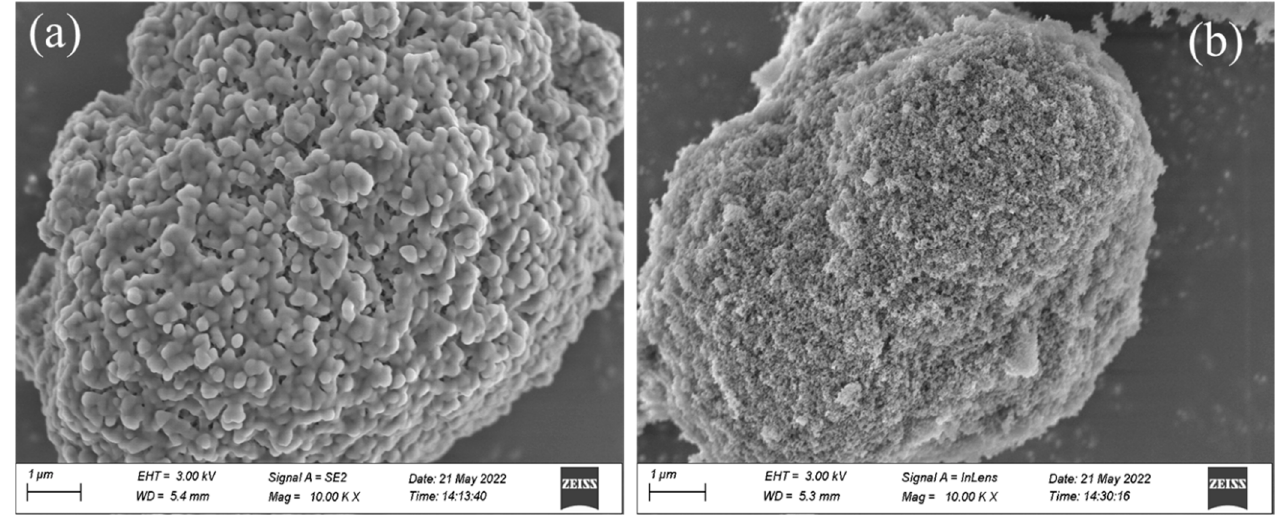
Figure 4. SEM images of composite shaped PCM for ( a ) PEG-400/SiO 2 and ( b ) Tet/SiO 2